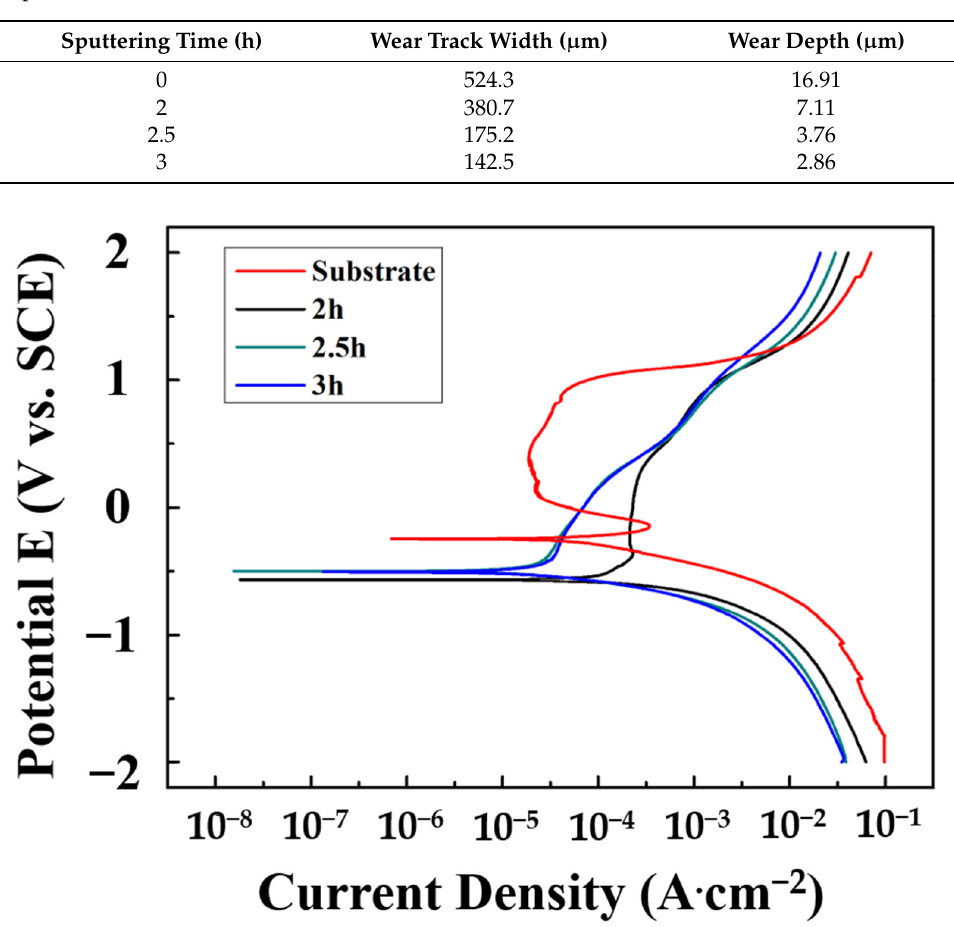
Table 4. Wear track width, and wear depth of CoCrNiSi0.3 MEA without and with CrN films deposited at different times.